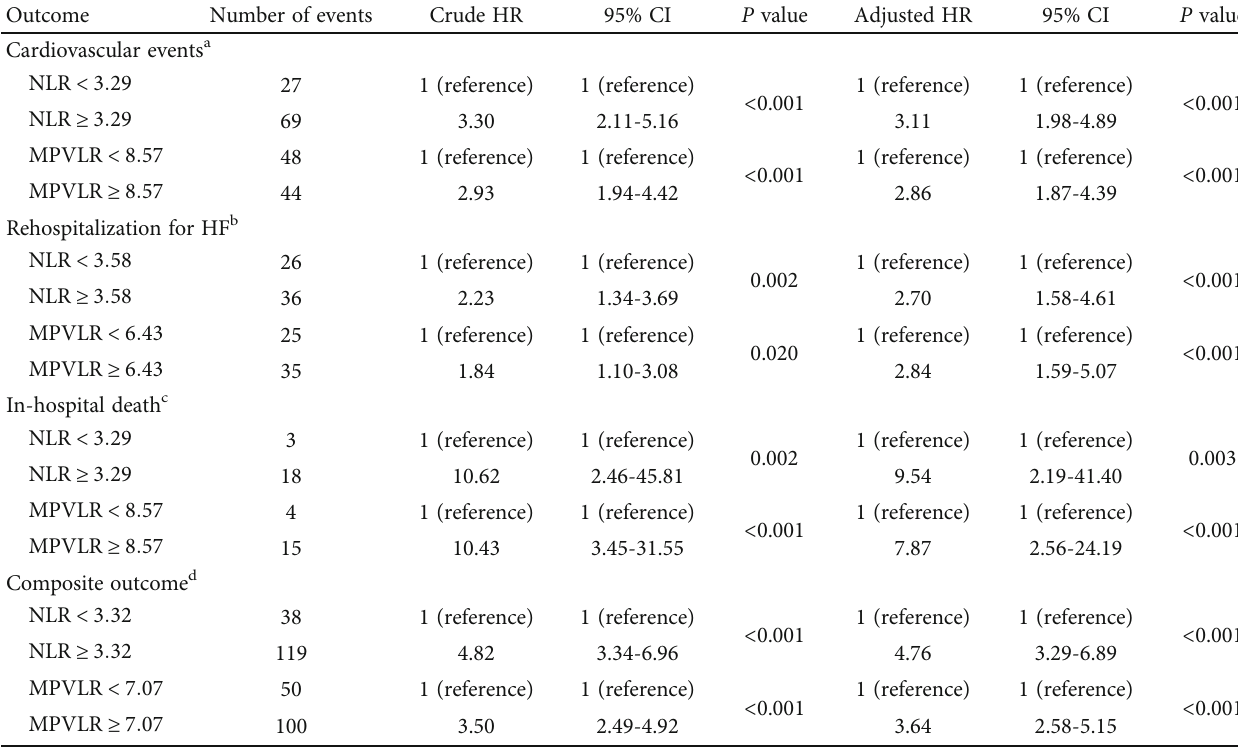
Table 3: Association of NLR and MPVLR with a prognosis of subsequent cardiovascular events and mortality in patients with heart failure. Outcome Number of